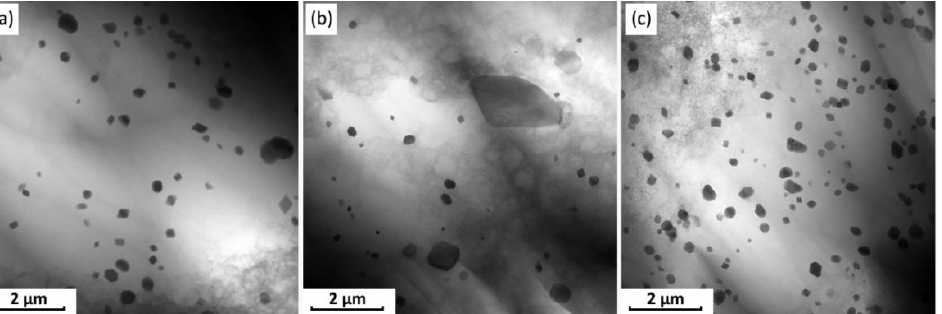
Figure 9. TEM images of the precipitates after brazing at 600 ℃ in ( a ) sample A, ( b ) sample B, and ( c ) sample C.